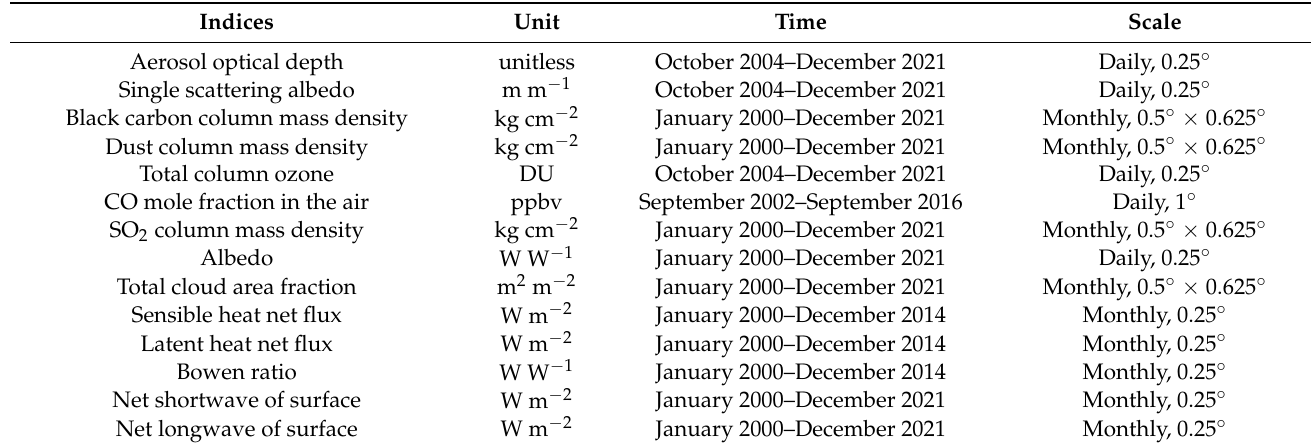
Table 2. The measurement information from satellites and the